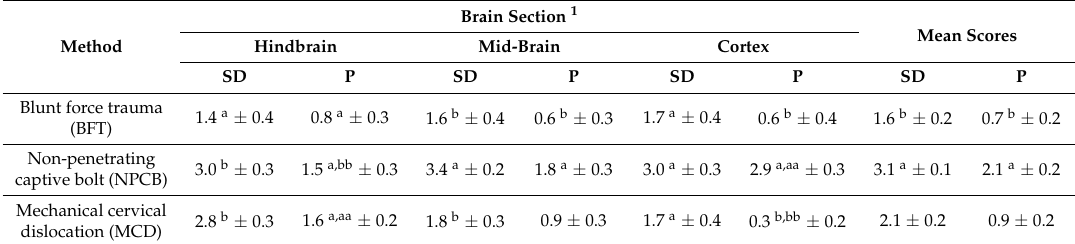
Table 3. Mean ( ± SE) subdural (SD) and parenchymal (P) microscopic hemorrhage scores across euthanasia methods and brain